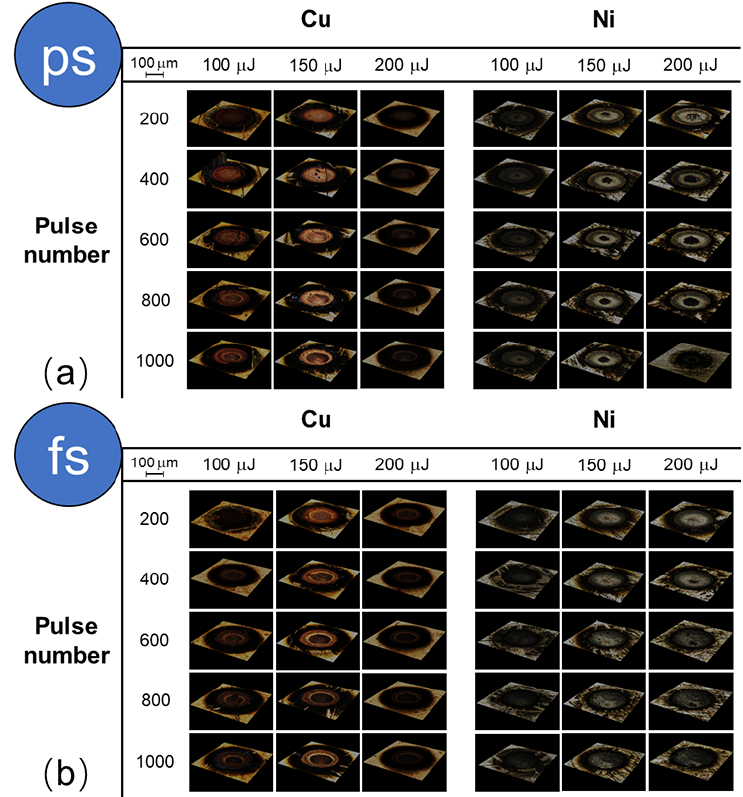
Figure 2. Surface ablation morphologies obtained by Laser confocal microscopy for Ni and Cu specimens under different pulse energies and number of pulses for: ( a ) PLMA; ( b ) FLMA.